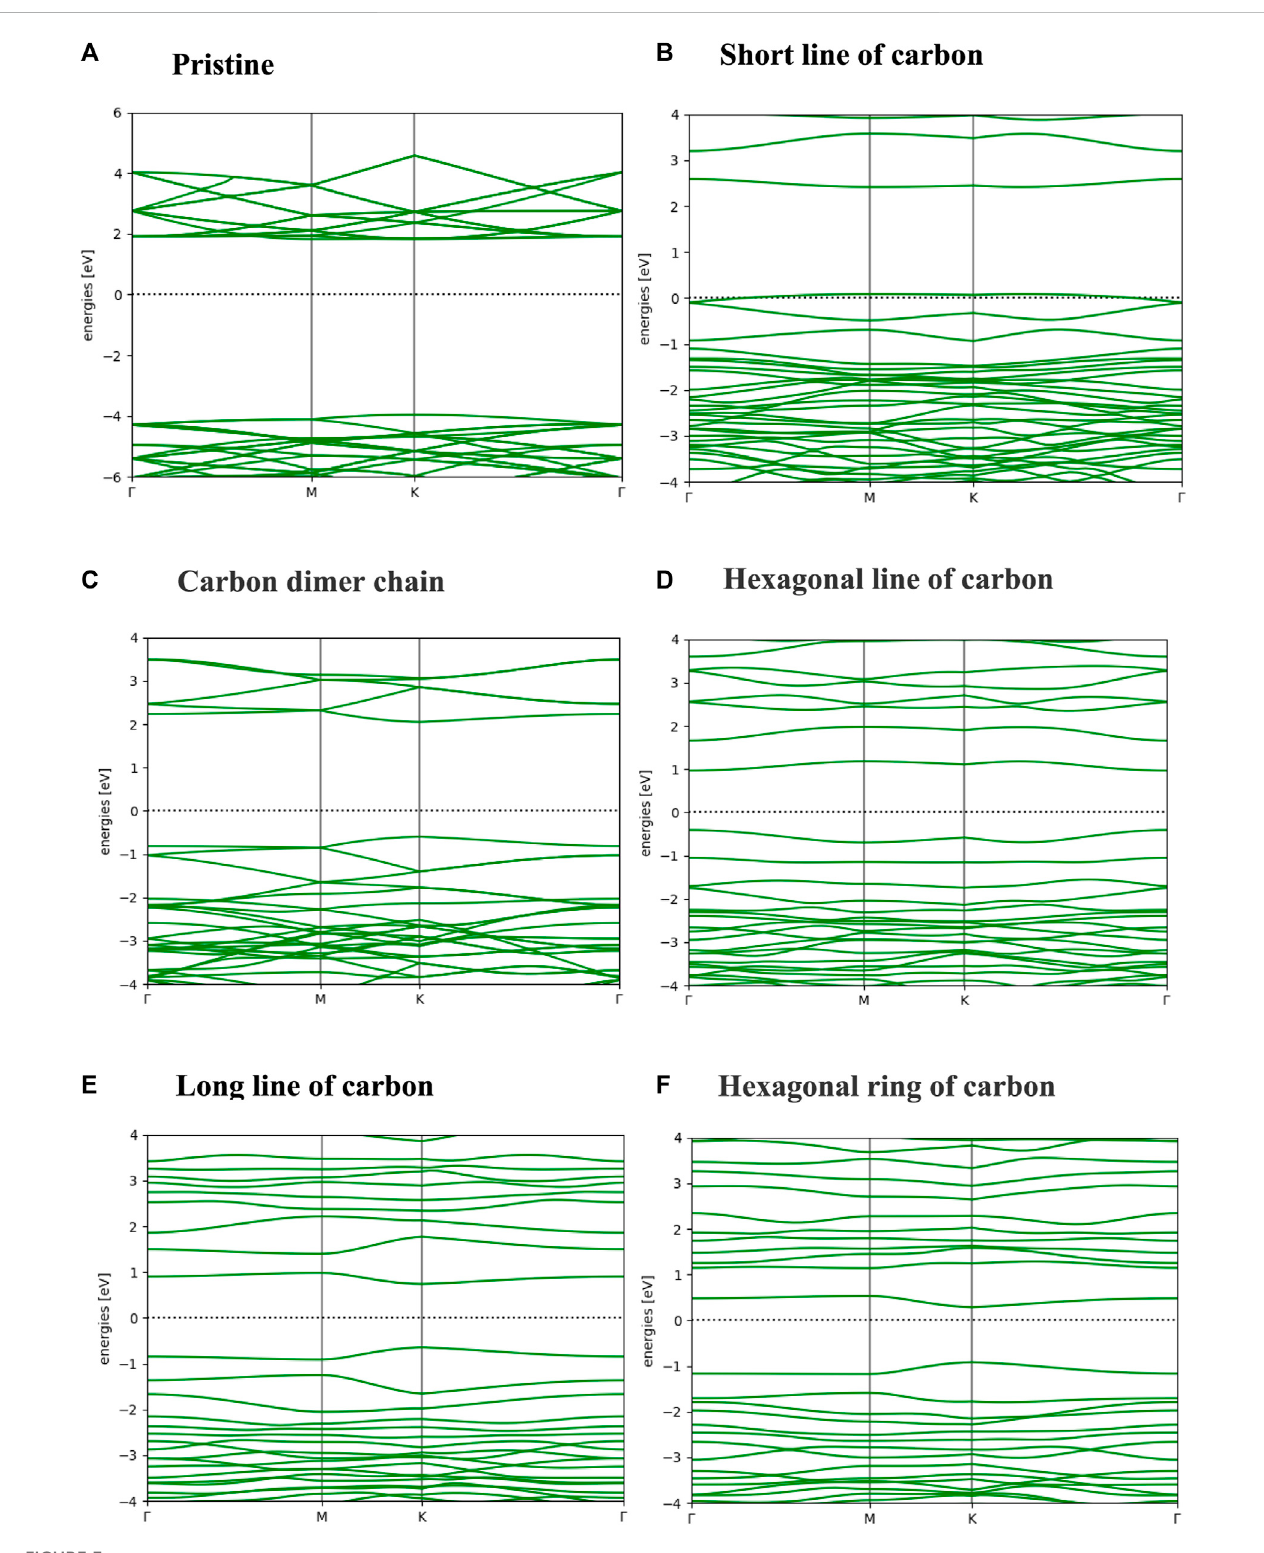
FIGURE 3 Electronic bandstructureofthenanolineembeddedmonolayerhexagonal boronnitrideshowingthepristinestructure (A) andashortlineofcarbon (B) , a carbon dimer chain (C) , a hexagonal line of carbon (D) , a long line of carbon (E) , and a hexagonal ring carbon (F)